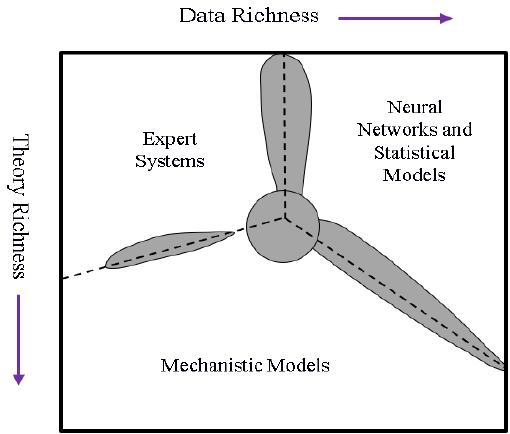
Figure 1. Suitable modelling techniques as function of theory and data richness, modified from [38].